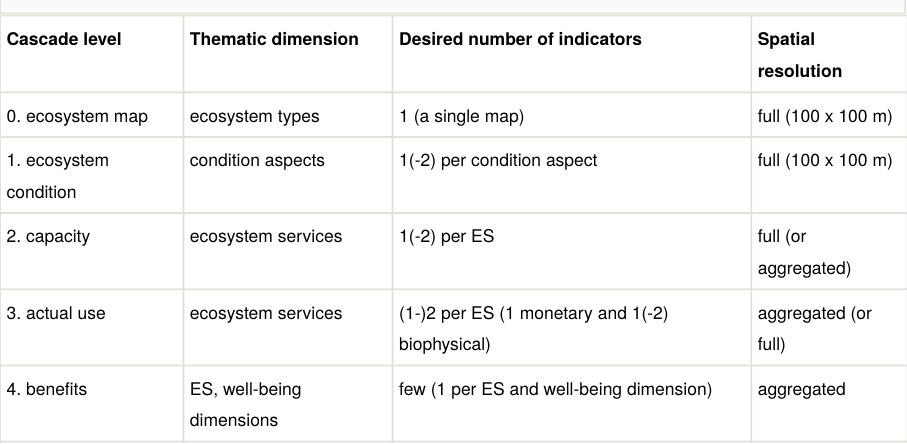
Assessment goals as de fi ned by the conceptual framework (CF): the type of information (number and type of indicators and the underlying typologies) sought by Niraj-MAES for each element of the